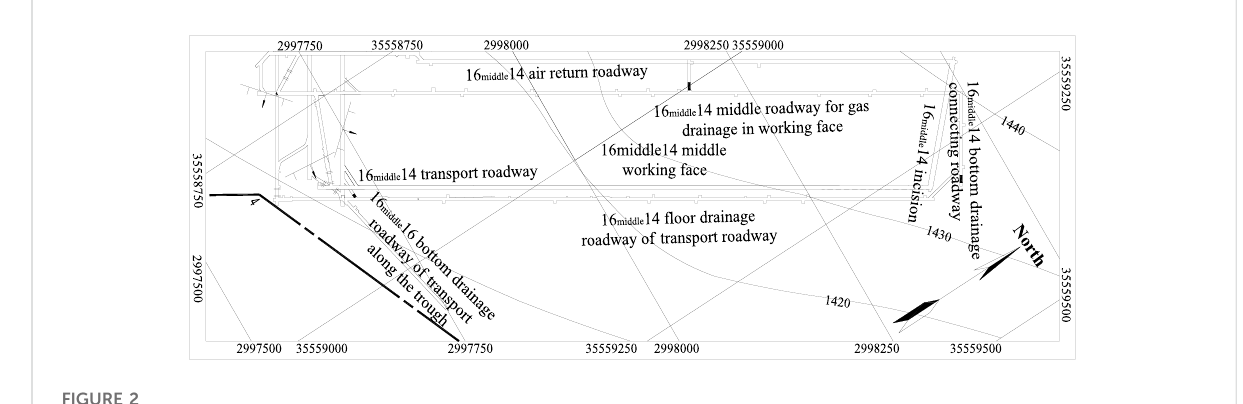
FIGURE 2 Occurrence of coal seams in the tested